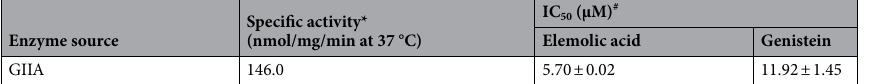
Table 2. IC 50 value of elemolic acid for GIIA inhibition. *nmoles of fatty acid released/mg of protein/min at 37 °C. # IC 50 value is defined as the amount of inhibitors (µM) required to inhibit 50% of enzyme activity. The IC 50 concentration was calculated using a Graph pad prism